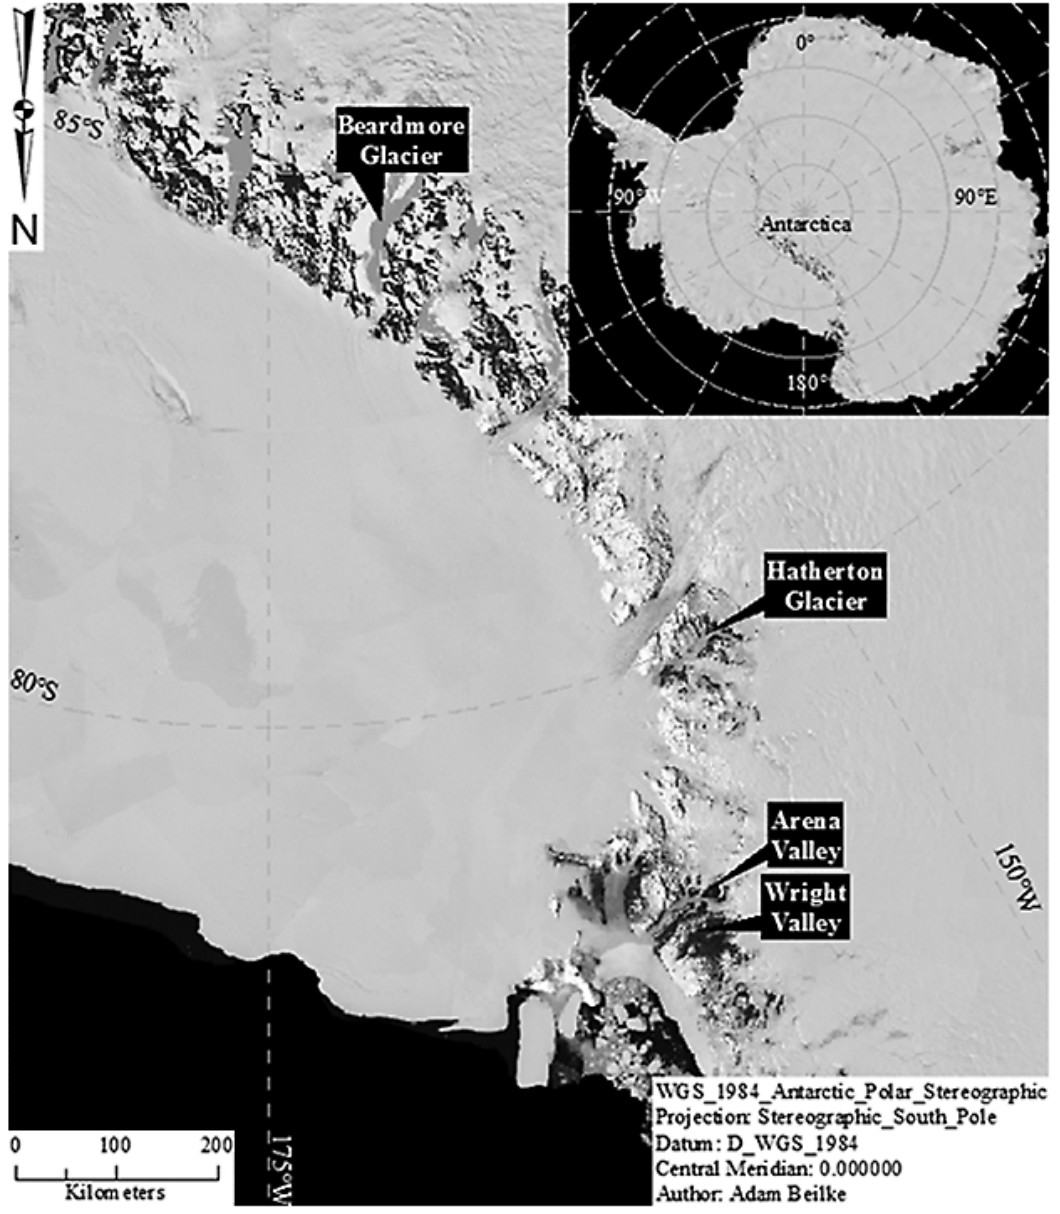
Fig. 1. Study areas in the Transantarctic